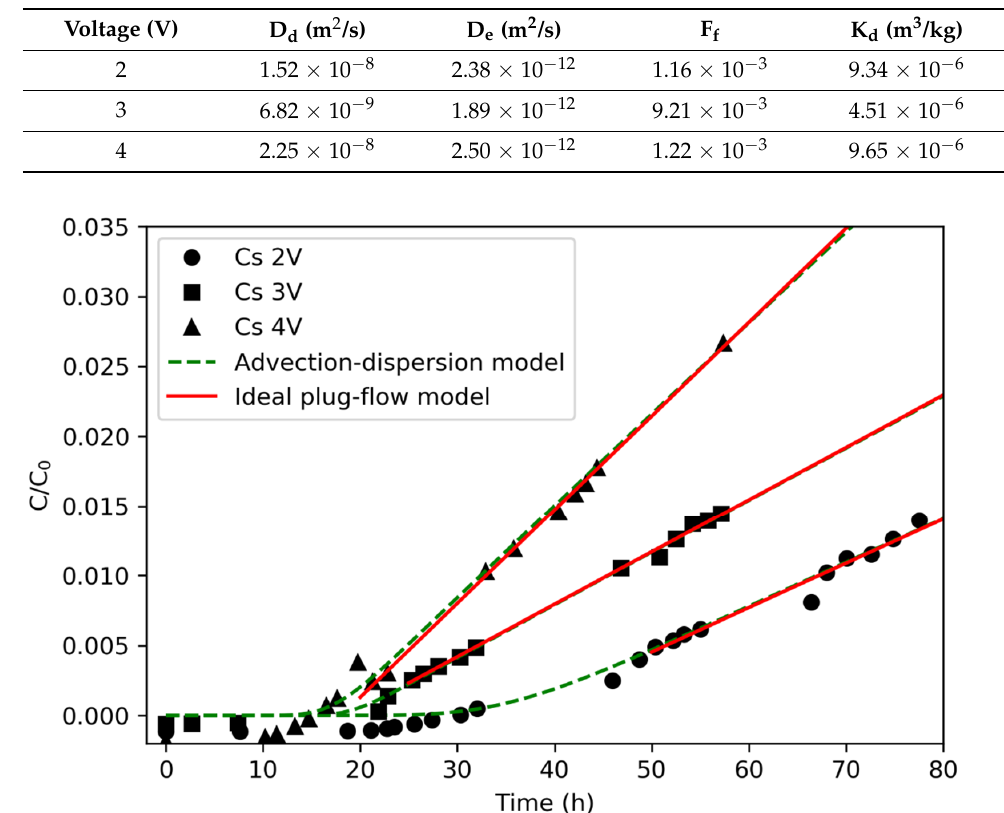
Figure 7. The concentration of Cs + ions followed in the recipient chamber as a function of experimen- tal time in the electromigration